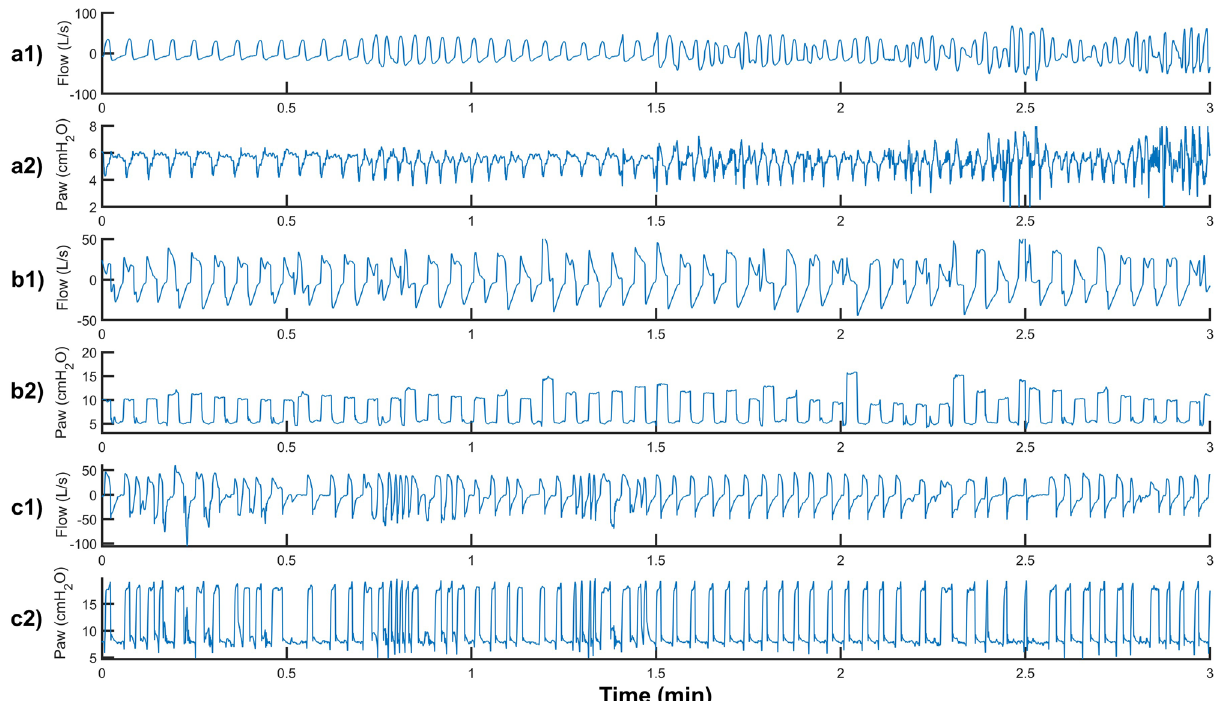
Figure 1. Tracing of Flow and Paw from three different patients. ( a ) Continuous Positive Airway Pressure (CPAP) of 6 cmH 2 O. ( b ) Pressure assist-control ventilation (PCV) with pressure of 10 cmH 2 O, ( c ) PSV with a pressure support of 10 cmH 2 O and PEEP of 8 cmH 2 O. In ( a1 ) and ( a2 ), Complex Patient-Ventilator Interactions (CP-VI) consists of an increase in respiratory rate > 50%; in ( b1) and ( b2 ), it consists of > 30% asynchronies (ineffective expiratory effort, double cycling, premature cycling, prolonged cycling, and/or reverse triggering) in the 3-min period; and in ( c1 ) and ( c2 ) it consists of a combination of change in the respiratory rate and